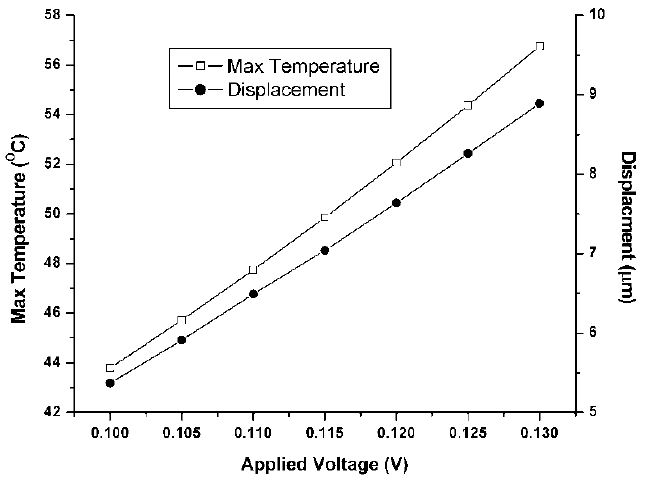
Figure 13. Drive direction displacement and maximum temperature when a static voltage is applied.